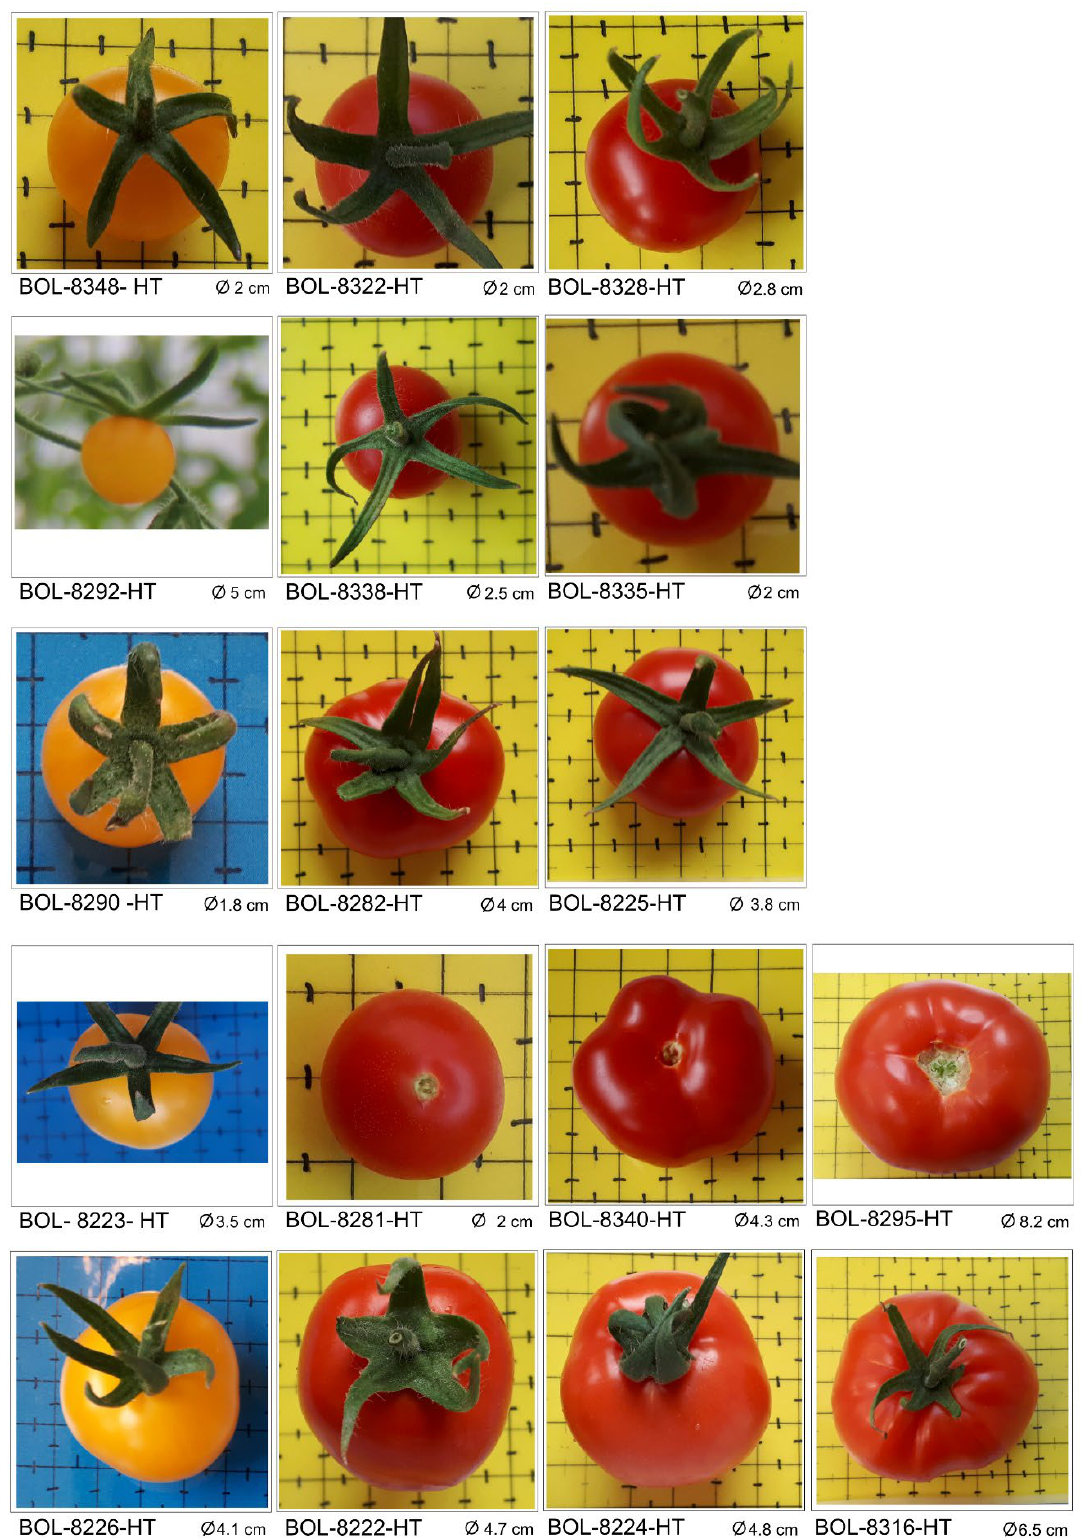
Figure 1. Images of 17 mature tomato fruits from Bolivian core germplasm.